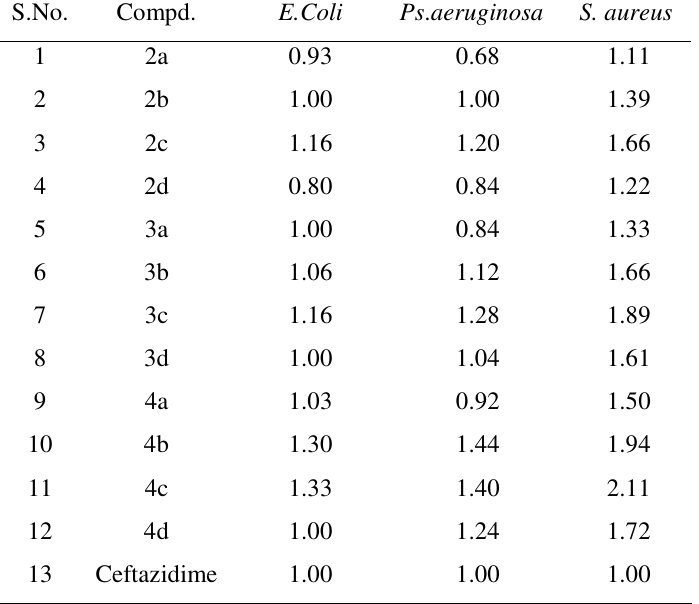
Table 2 . Antibacterial activity of synthesized compounds